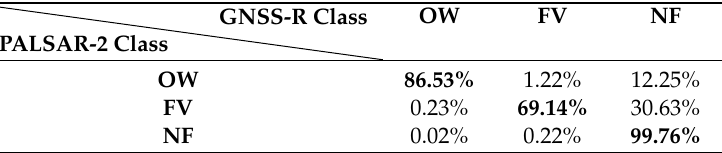
Table 4. Accuracy results of the GNSS-R inundation classification obtained with the MDTR algorithm. The confusion matrix displays the accuracy results of the classification algorithm built using corrected